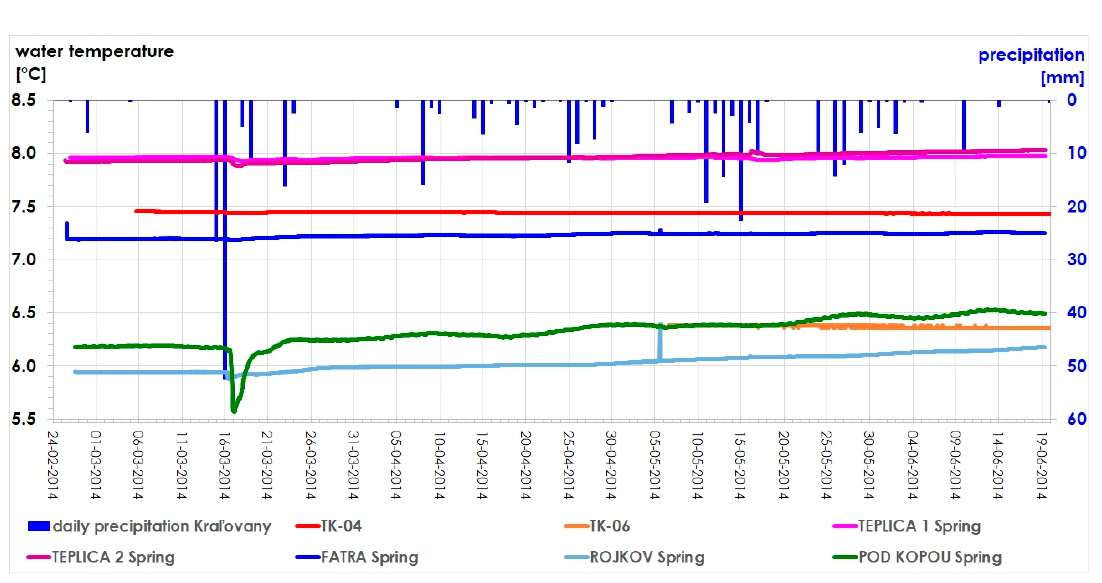
Figure 9. Daily precipitation in Kra ľ ovany and groundwater temperatures in the Rojkov and Pod Kopou Springs and the TK-06 borehole with visible influence of 15.03.2014–16.03.2014 precipitation event of water temperature in springs.